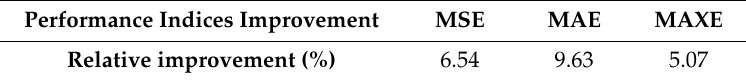
Table 6. Relative performance improvement of the SMO-based estimator over the phasor diagram based estimator during dynamic disturbances of reactive power for generator operating point P = 0.89, Q = 0.11 cap.